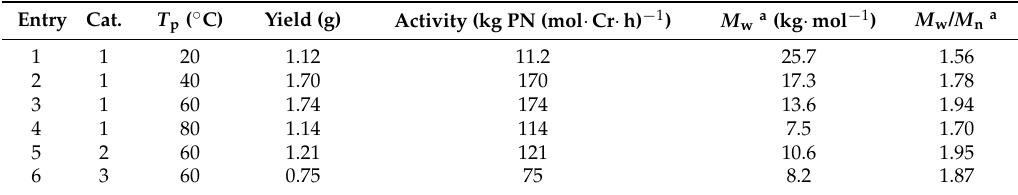
Figure 2. DSC curves of PE obtained by 1 /MAO at different temperatures. Table 2. Norbornene polymerizations with 1-3 /MAO.